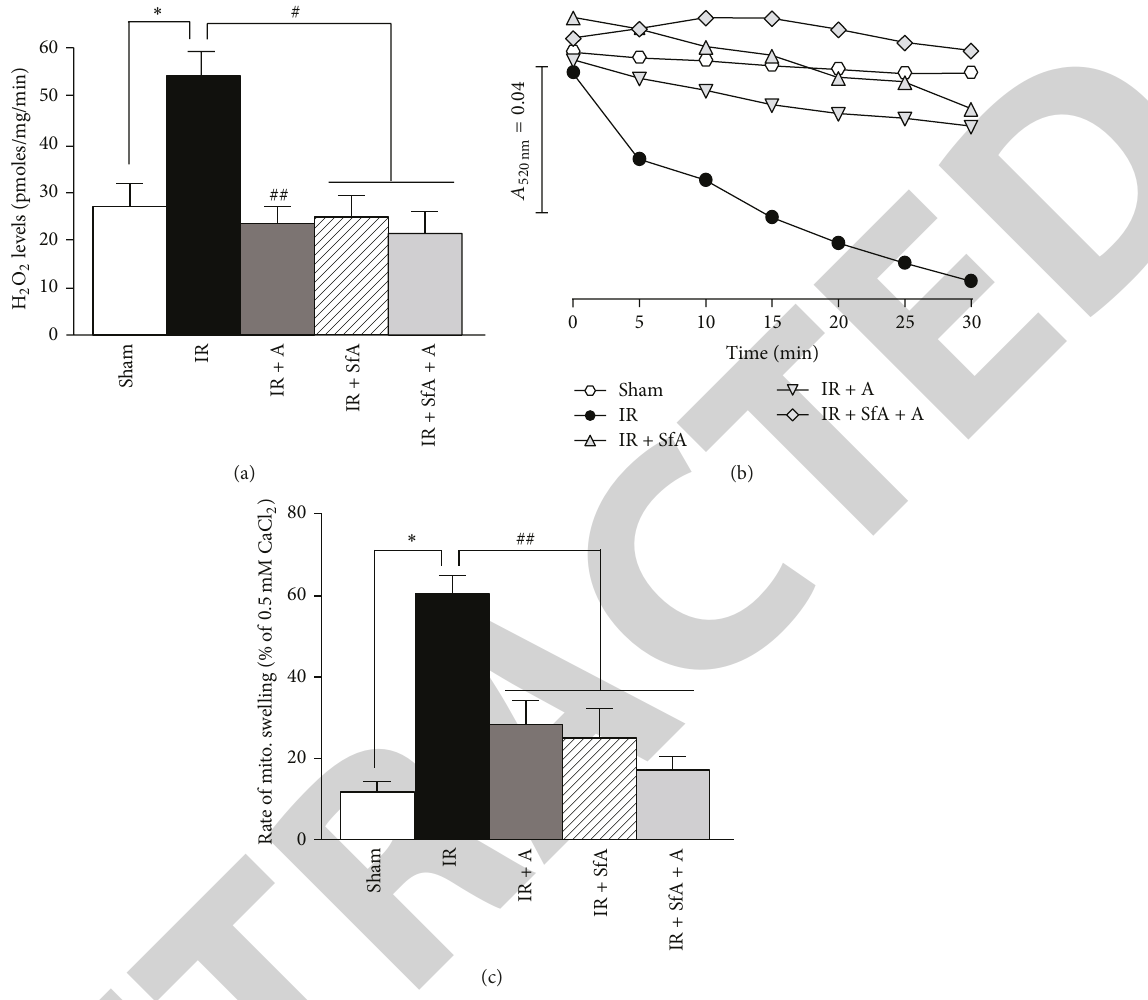
Figure 4: ROS levels and Ca 2+ -induced mitochondrial swelling as an indicator of PTP opening in cardiac mitochondria isolated from rats treated with A-769662 (A) and/or SfA. (a) ROS levels in mitochondria, expressed as pmoles of H 2 O 2 per mg of protein per minute. (b) Representative traces of mitochondrial swelling, shown as calcium-induced decrease in light scattering at 520 nm. (c) Quantitative data of PTP opening, shown as the rate of swelling and expressed in percentage of maximum swelling induced by 0.5 mM CaCl 2 . The number of animals: Sham ( 𝑛 = 7 ), IR ( 𝑛 = 8 ), IR + SfA ( 𝑛 = 4 ), IR + A-769662 ( 𝑛 = 6 ), and IR + SfA + A ( 𝑛 = 4 ). ∗ 𝑃 < 0.01 versus Sham; # 𝑃 < 0.01 versus